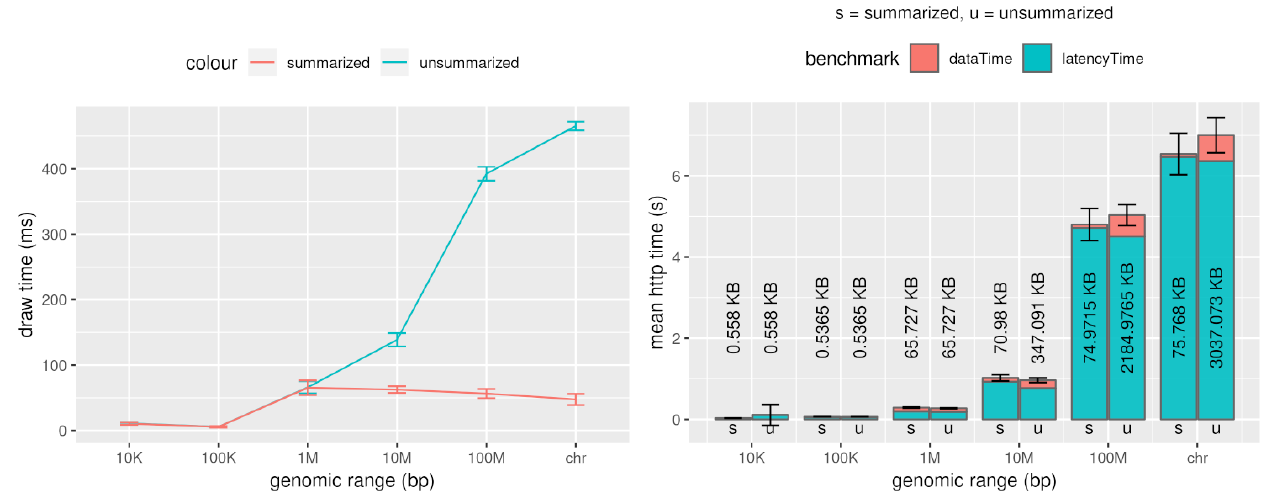
Figure 6. Effect of data summarization on the Epiviz Python data. Here we compare average data request and data rendering time for continuous data along the genome to study the effect of summarizing data on the data backend across 10 runs. Lines for ‘unsummarized (u)’ correspond to the previous Epiviz implementation where all data within a genomic region is returned by the php-backend to the web browser client. Lines for ‘summarized (s)’ correspond to our new implementation of the python-data backend, where data summarization within genomic regions is performed in the backend. The left panel shows the mean draw times between these scenarios where we see a significant improvement in the draw times when the data is summarized in the backend. The bar plot in the right panel shows the total http time and is separated to show mean latency times and data transfer times. The number of bytes transferred for summarized and unsummarized backends is also displayed. The error bars represent one standard deviation away from the mean draw time in the left panel and mean http time in the right panel. We observe that the total http request time (summarization plus data transfer) is comparable to transfer time for the larger unsummarized data scenarios.